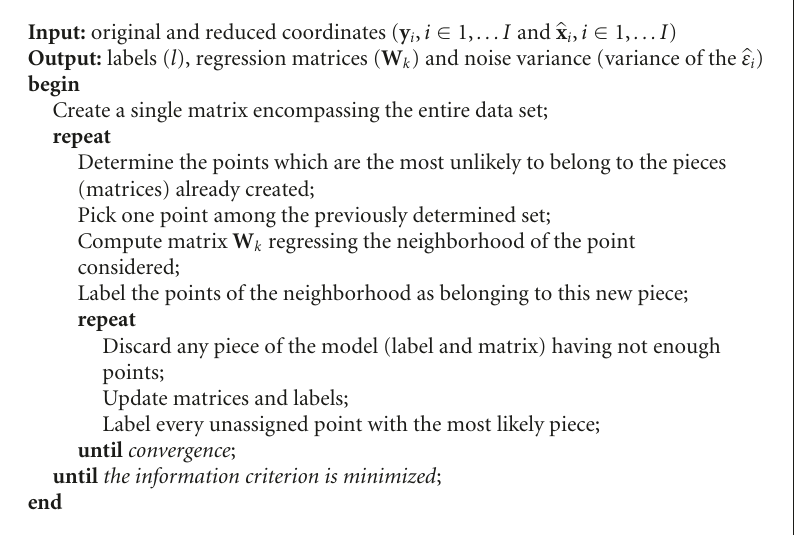
Algorithm 4: Piecewise linear mapping 2 (PLM 2).